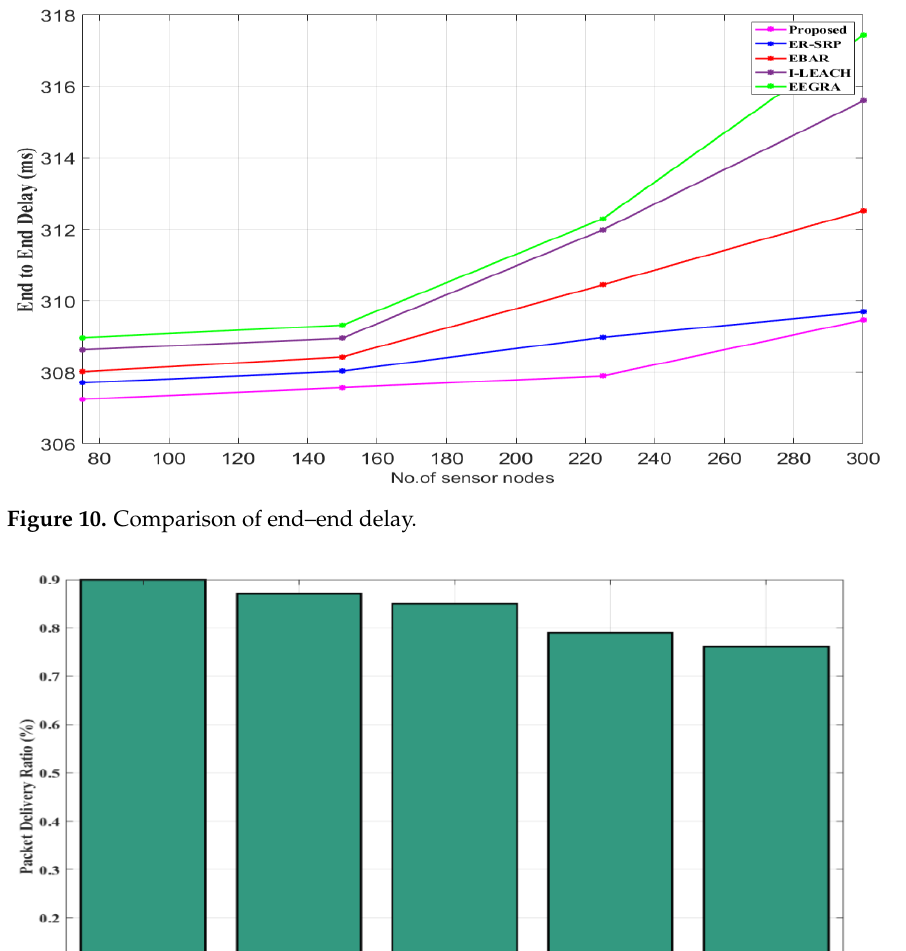
Figure 10. Comparison of end–end delay.